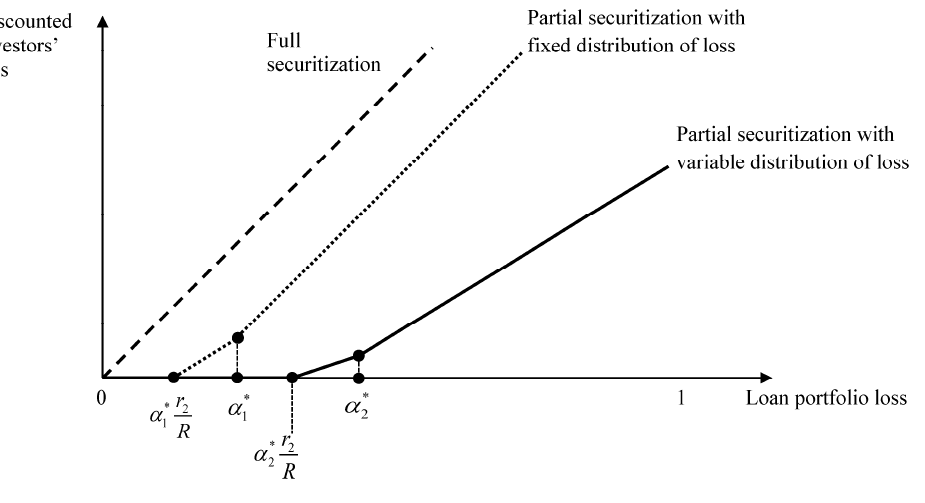
Figure 1. Optimal securitization contract with credit enhancement and different assumptions on the conditional distribution of loss. Investors’ discounted loss equals 0 when L < α ∗